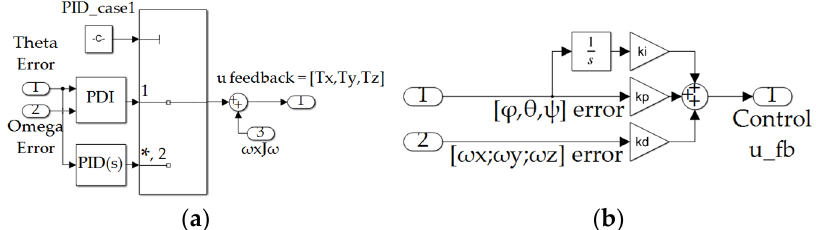
Figure A5. ( a ) Feedback controller subsystem depicted in Figure A3; ( b ) proportional, derivative, integral controller depicted in subfigure ( a ).